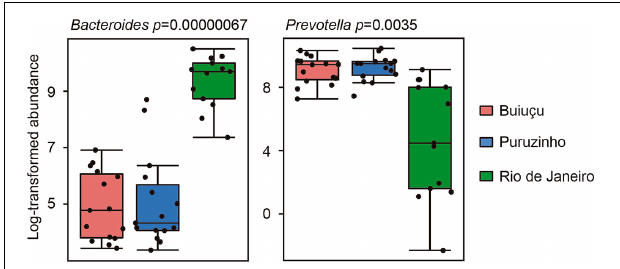
FIGURE 3 | Box plots showing relative abundance of the two bacterial genera showing the highest correlation with the Amazon versus Rio de Janeiro sample groups. Correlation was measured using the Pattern Search tool in MicrobiomeAnalyst, with Pearson r as the distance measure.